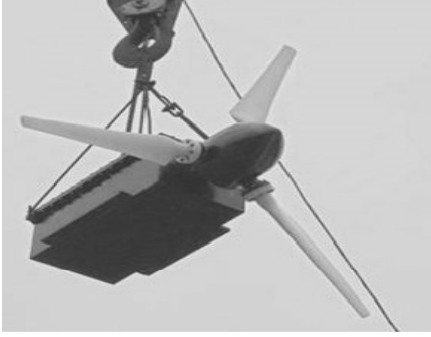
Figure 3. Turbine of the Marine Current Turbines Ltd.